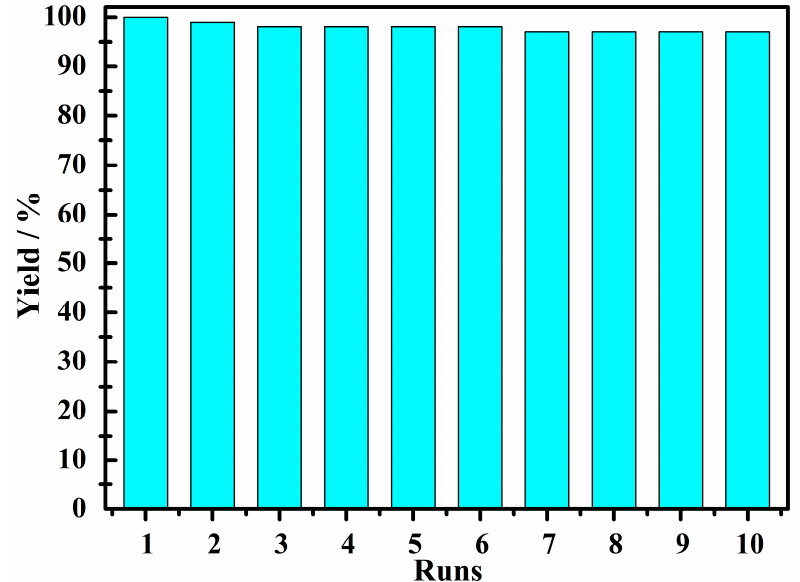
Figure 3. Recovery and reuse of the catalyst 1 . The GC yield (%) based on 1-phenylethanol to acetophenone under optimized reaction conditions.